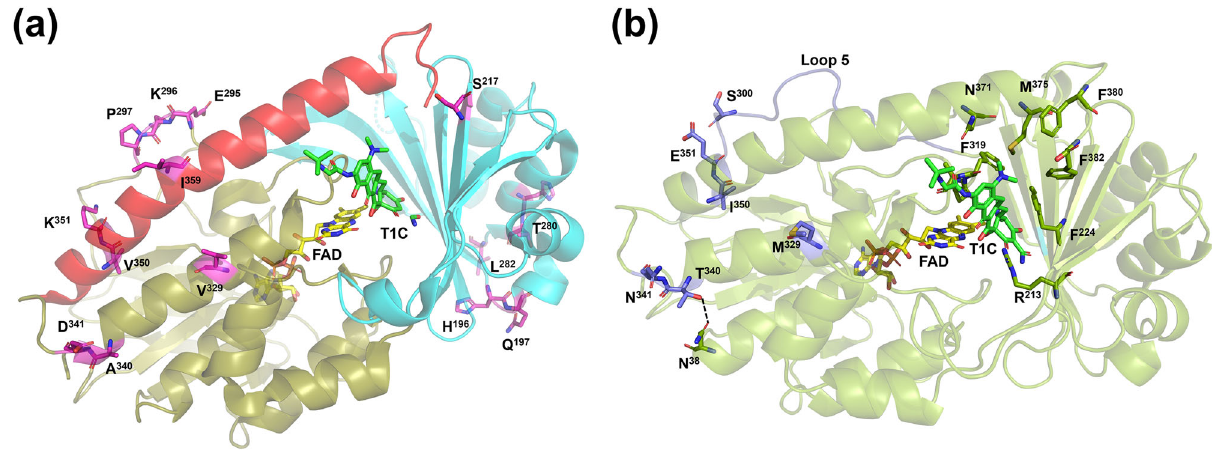
Fig. 2 Location of related residues in the Tet(X)-tigecycline complex structure. a Mapping the test amino acid substitution sites in the FAD-binding domain (deep olive), substrate-binding domain (cyan), and C-terminal helix (red). Residues are depicted as pink stick. b FAD and substrate-binding sites and mutation residues are showed in the model of Tet(X2) mutant (V 329 M/A 339 T/D 340 N/V 350 I/K 351 E). Loop 5 and mutant residues are shown as deep blue. Substrate-binding sites are depicted as green